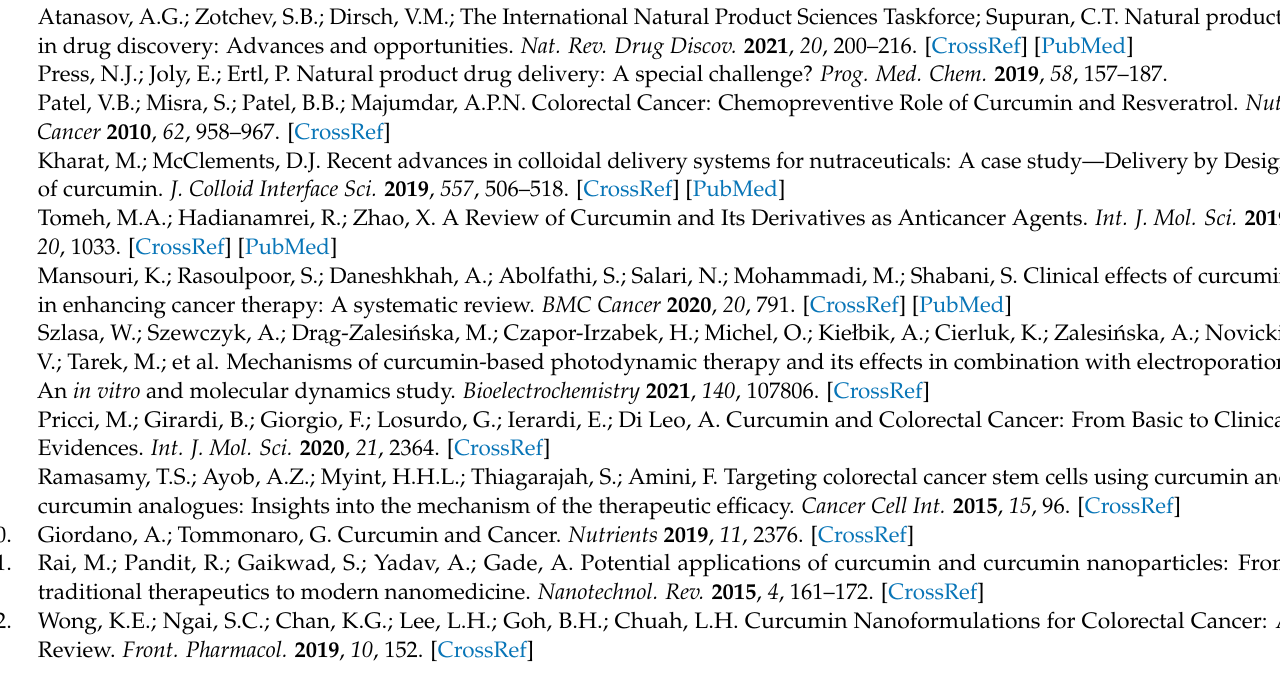
Figure S1: UV-Vis spectra recorded for CUR dissolved in acetone (C = 10 µ g/mL) and extracted from CA10UM and CA10UX particles; Table S1: Kinetic parameters of hybrid (H) and Korsmeyer– Peppas (KP) models estimated from the fitting to experimental data received during the simulated gastric fluid (SGF) stage of the in vitro release of CUR. Bold type indicates the best fit; Table S2: Kinetic parameters of hybrid (H) and Korsmeyer–Peppas (KP) models estimated from the fitting to experimental data received during the simulated intestinal fluid (SIF) stage of the in vitro release of CUR. Bold type indicates the best fit; Table S3: Kinetic parameters of hybrid (H) and Korsmeyer– Peppas (KP) models estimated from the fitting to experimental data received during the simulated colon fluid (SCF) stage of the in vitro release of CUR. Bold type indicates the best fit; Table S4: One-way ANOVA multiple comparison results; red color denotes statistically significant